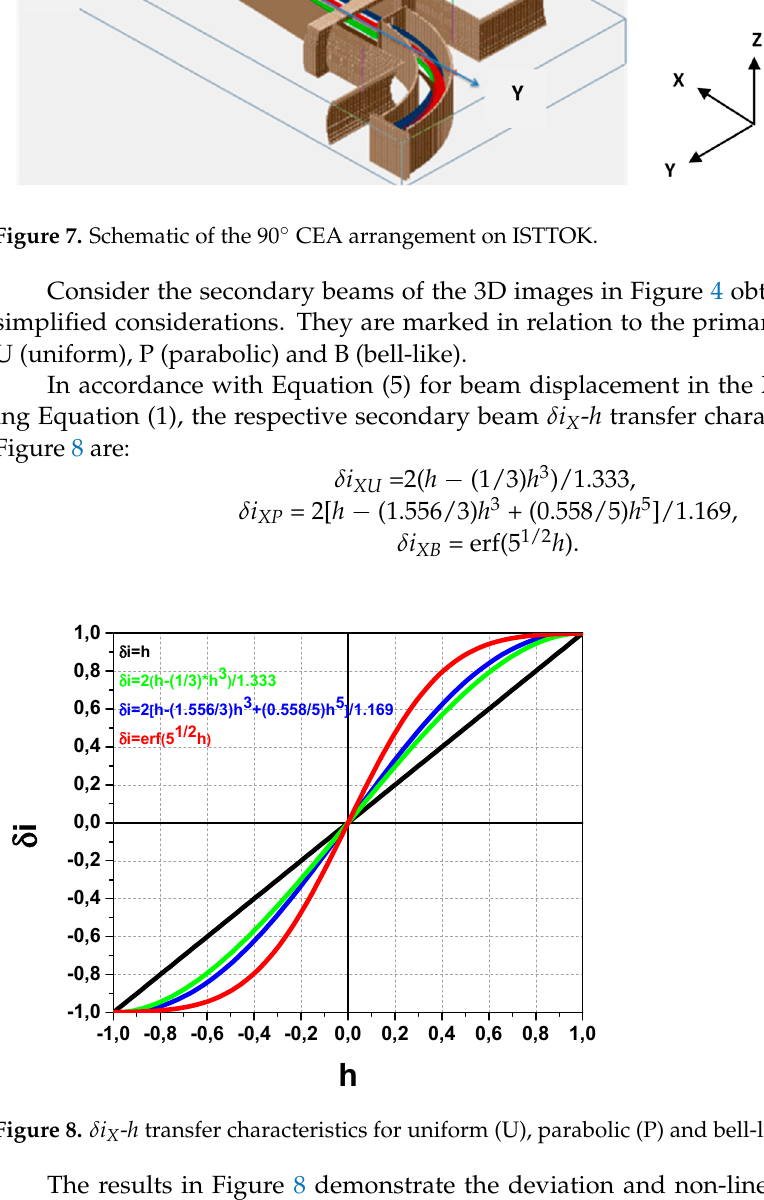
Figure 7. Schematic of the 90° CEA arrangement on ISTTOK.